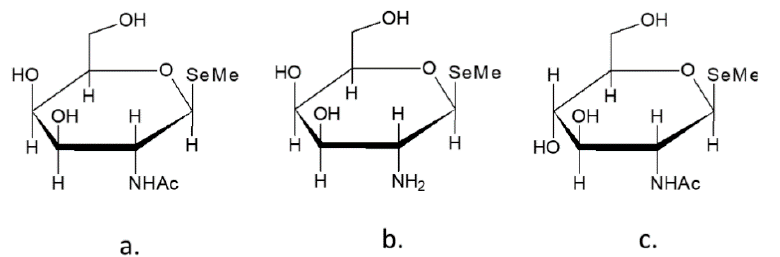
Figure 5. Three selenoglycosides detected as urinary selenium metabolites within the required to low-toxic range: ( a ) 1 β -methylseleno- N -acetyl-D-galactosamine, ( b ) 1 β -methylseleno-D-galactosamine, and ( c ) 1 β -methylseleno- N -acetyl-D-glucosamine .